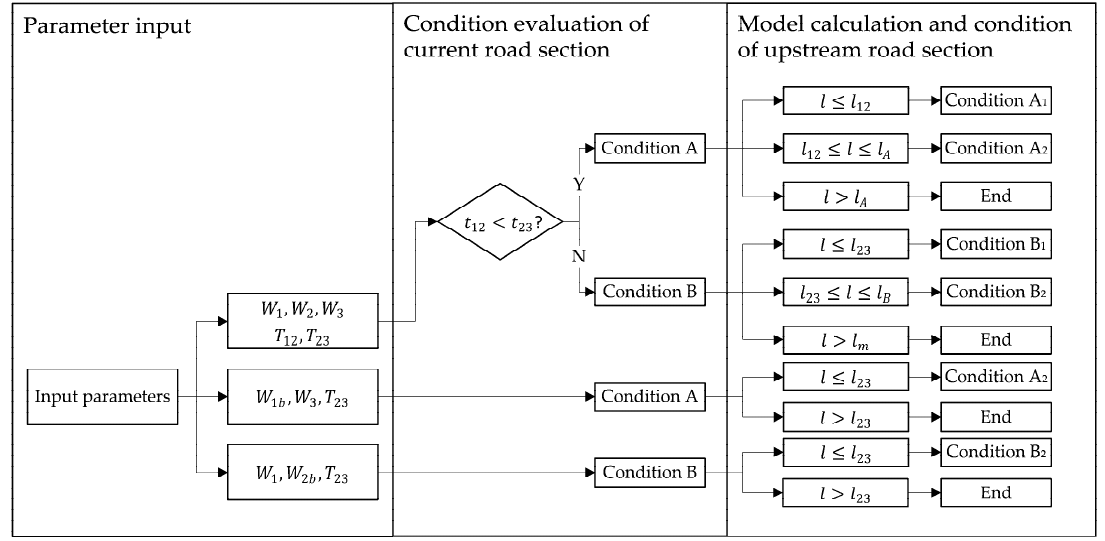
Figure 5. Overall procedure of condition evaluation of current and upstream road sections.